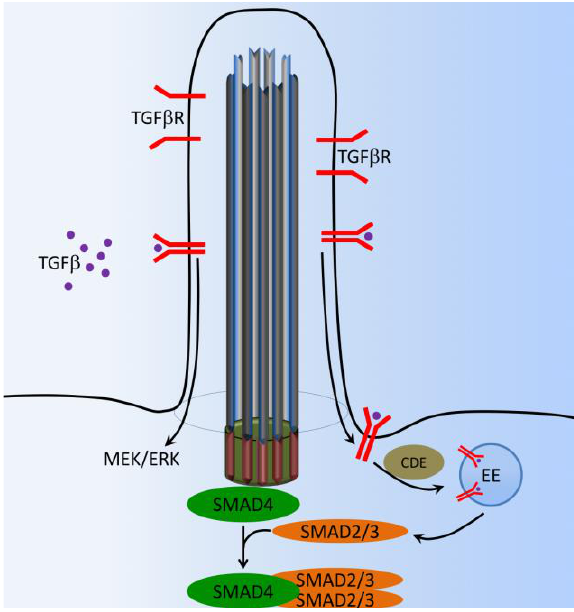
Figure 7. Cilia-dependent TGF-β signaling. In the presence of TGF-β, activated TGF-β receptors (TGF-β1 and TGF-β2) translocate from the ciliary membrane to the ciliary pocket (CiPo) for clathrin-dependent endocytosis (CDE) and activation of SMAD transcription factors 2/3 (SMAD2/3) in early endosomes (EE) at the ciliary base. SMAD2/3 forms a trimeric complex with SMAD4 for nuclear translocation and activation of TGF-β target genes. Ciliary TGF-β signaling also involves the activation of ERK1/2.